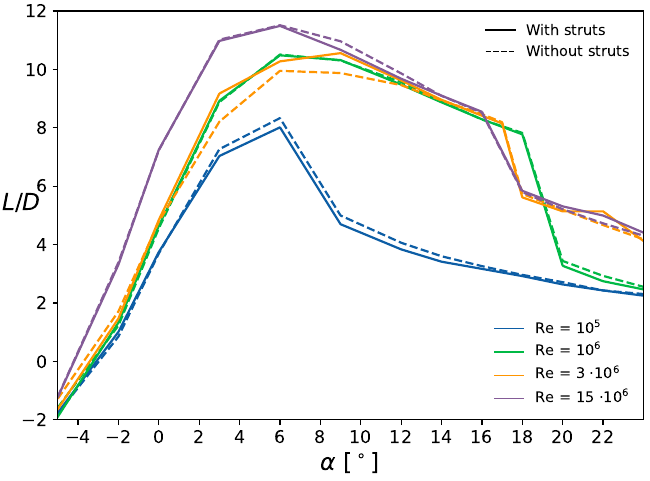
Continuous lines correspond to the wing with struts, whilst dashed lines are for the wing without struts.